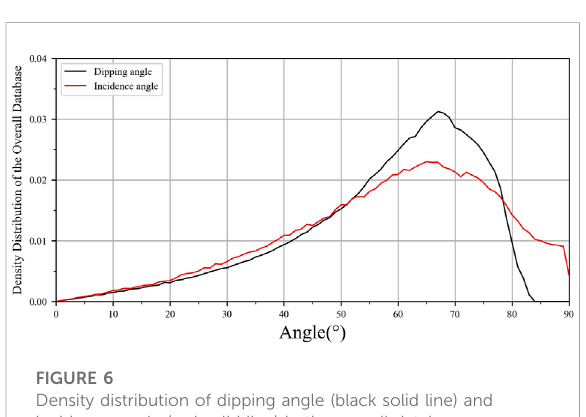
FIGURE 6 Density distribution of dipping angle (black solid line) and incidence angle (red solid line) in the overall